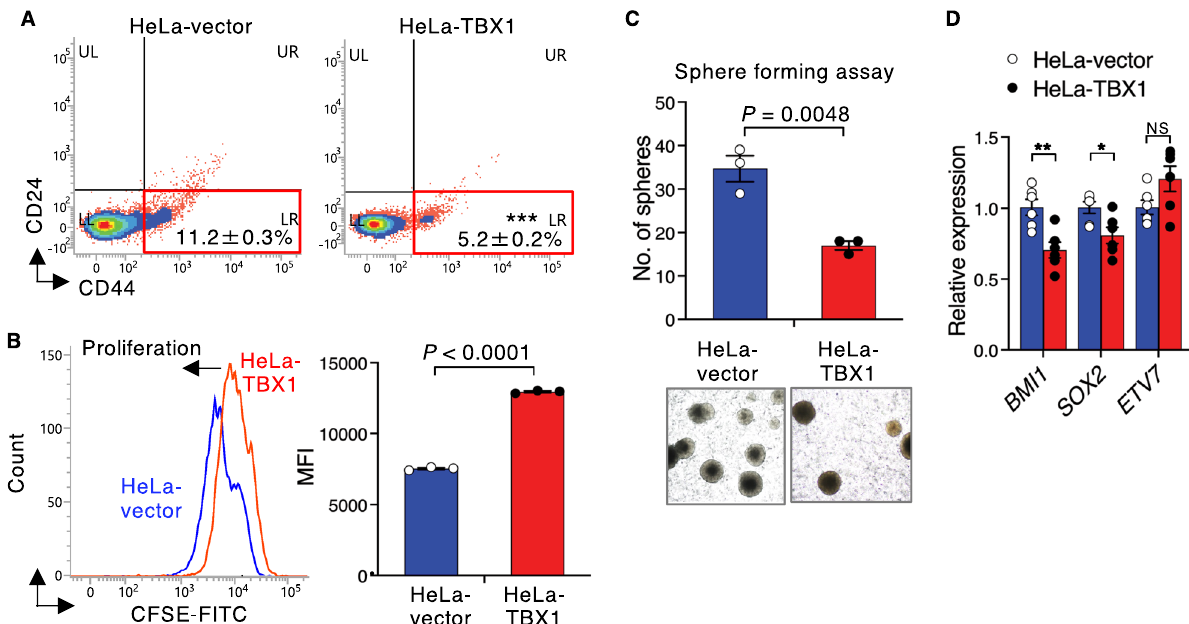
Figure 2. TBX1 suppresses stem cell properties. ( A ) Flow cytometric analysis of CD24 and CD44 expression in empty vector (HeLa-vector) and TBX1 stably transfected HeLa cells (HeLa-TBX1). The percentage of CD44 + CD24 − stem cell population (lower right box) is indicated ( n = 6). ( B ) Flow cytometric analysis of HeLa-vector and HeLa-TBX1 cells labeled with CFSE fluorescent dye. A representative day 2 histogram (left) and the mean ± s.e.m. of quantified results from three independent experiments with replicate wells (right) are shown (see also Supplementary data, Fig. S3A). MFI, mean fluorescence intensity. ( C ) Sphere-forming capacity of HeLa-vector and HeLa-TBX1 cells ( n = 3). ( D ) Expression of stem cell markers was examined by qPCR in control HeLa-vector cells and HeLa-TBX1 cells ( n = 6). For ( A-D ), the results are presented as mean ± s.e.m.; * P ≤ 0.05, ** P ≤ 0.01, *** P ≤ 0.001; NS, not significant; unpaired two-tailed Student’s t